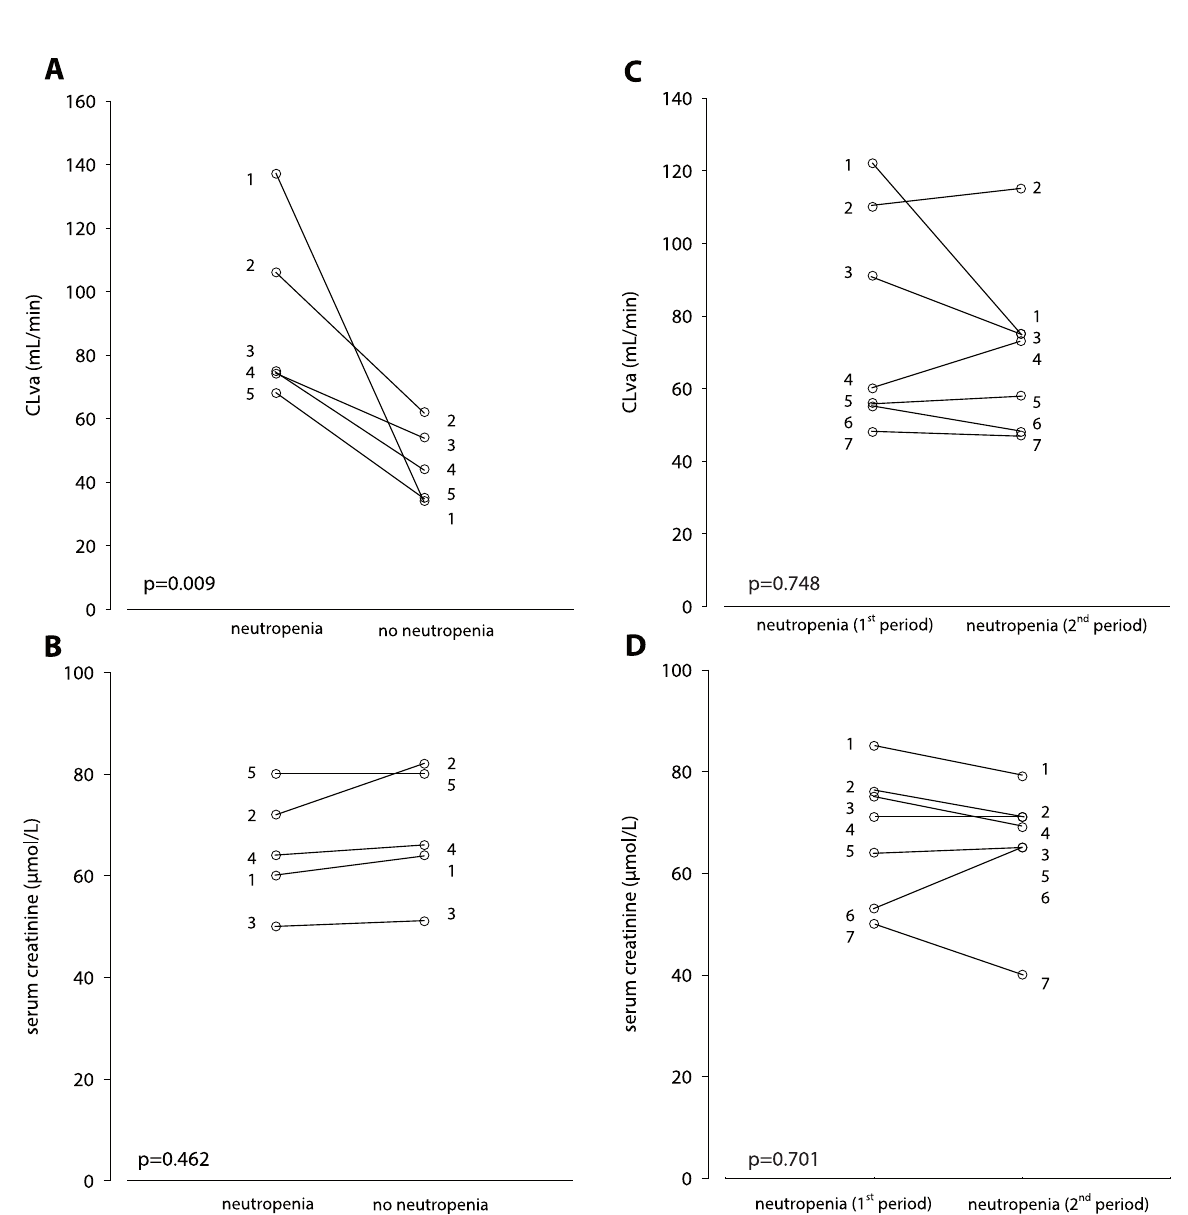
Figure 3. A. Vancomycin clearance (CLva) and B. serum creatinine of 5 patients (number 1–5) during both a neutropenic and a non- neutropenic phase and C. CLva and D. serum creatinine of 7 patients (number 1–7) during two neutropenic phases. doi:10.1371/journal.pone.0112008.g003 PLOS ONE |